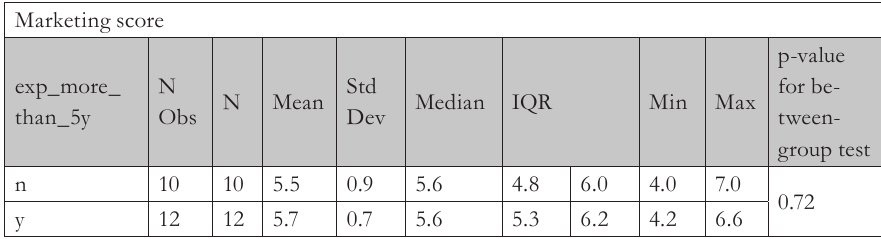
Tab. 6 – BI Managers work experience Marketing and non-Marketing scores